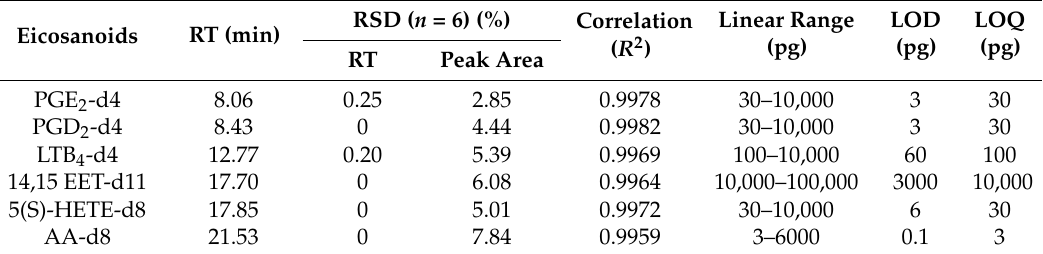
Table 2. Validation of the eicosanoid profiling method based on UPLC-MS/MS and the LOD and LOQ of each